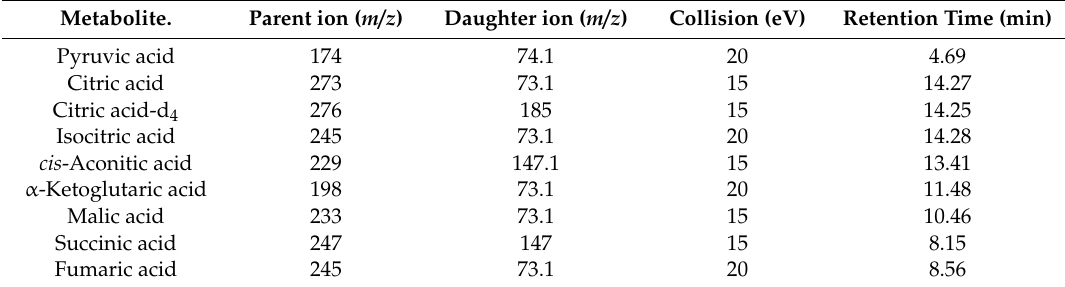
Table 1. Multiple reaction monitoring transitions and parameters for pyruvic acid, TCA cycle intermediates, and deuterated citric acid (internal